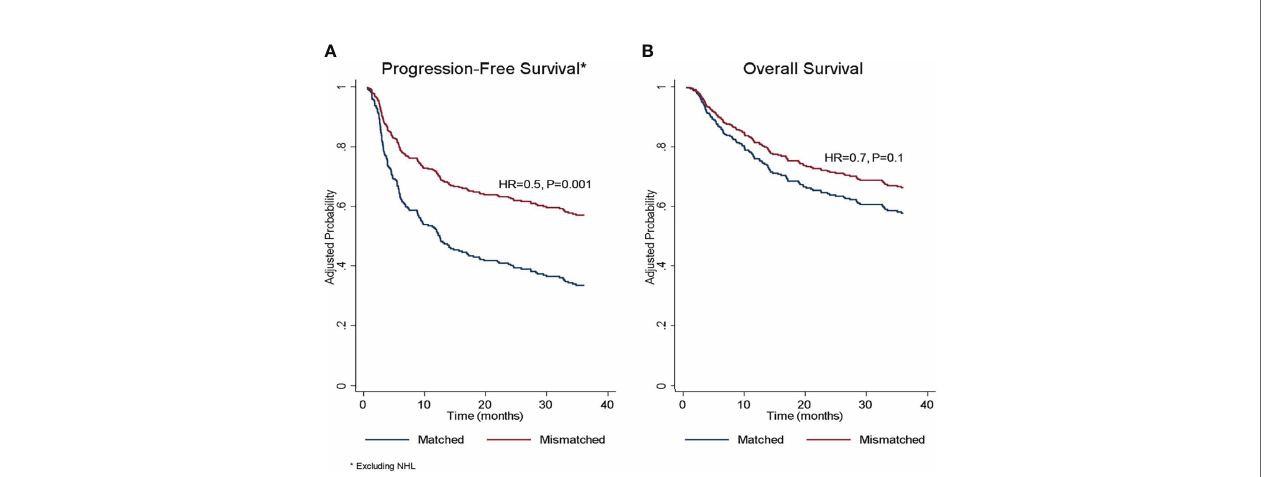
FIGURE 3 | Adjusted probability of (A) progression-free survival and (B) overall survival according to donor/recipient SIRP a match or mismatch status. HR, hazard ratio; NHL, non-Hodgkin lymphoma. *The protective effect of SIRP a mismatch was limited to diagnoses other than non-Hodgkin ’ s lymphoma.